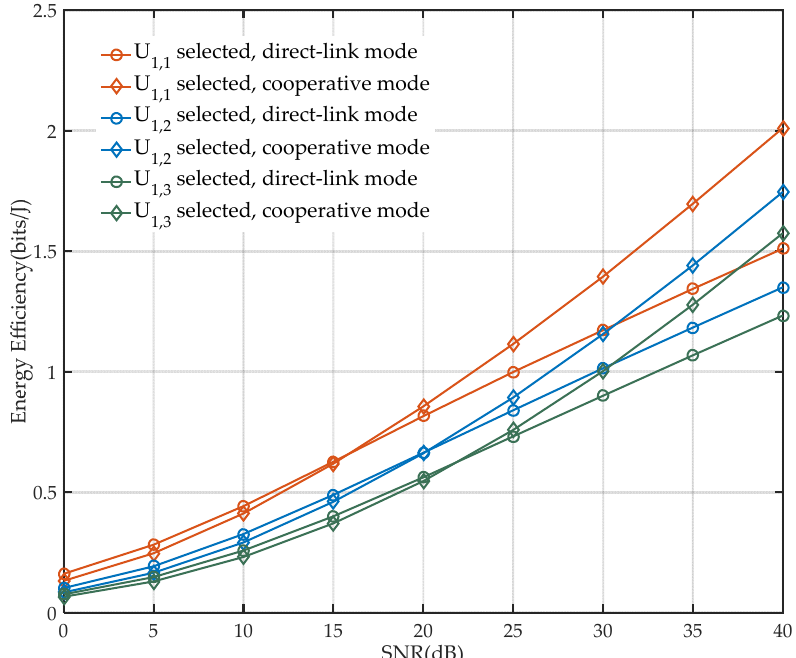
Figure 5. EE performance of networks under different user selections ( 𝑃 (cid:3046) = 10 , 𝑎 = 0.2 , 𝜌 = 0.6 ).